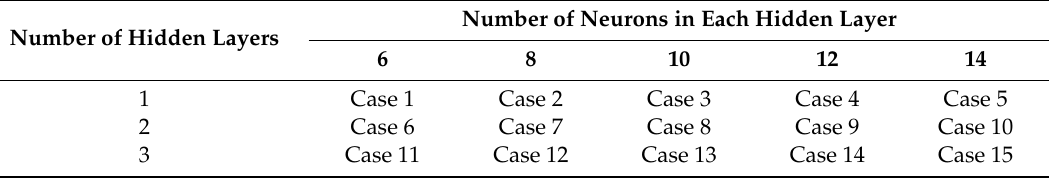
Table 1. Case studies considered in the model selection procedure. Number of Hidden